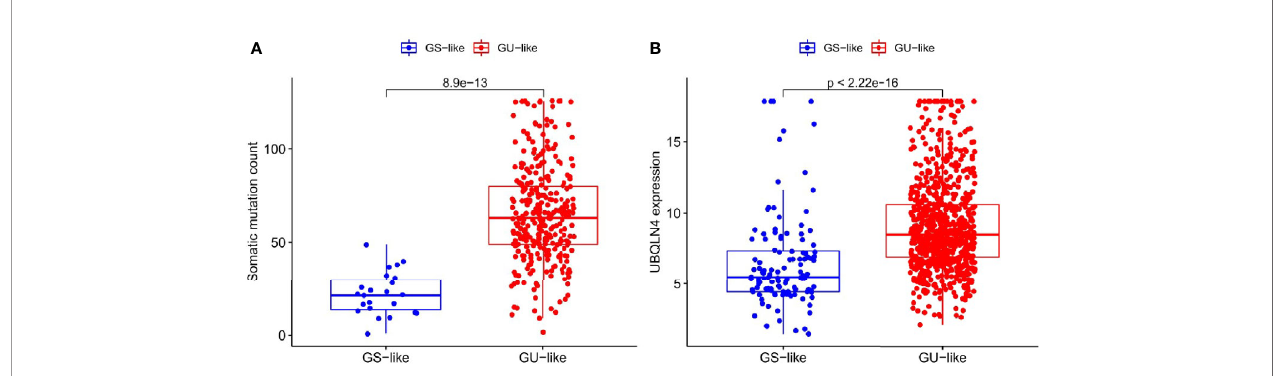
FIGURE 1 | Differences in somatic mutation counts and UBQLN4 between GU-like group and GS-like group. (A) Differences in somatic mutation counts between GU-like group and GS-like group. The mutation counts of the GS-like group were signi fi cantly lower than that of the GU-like group (P < 0.001, Mann – Whitney U